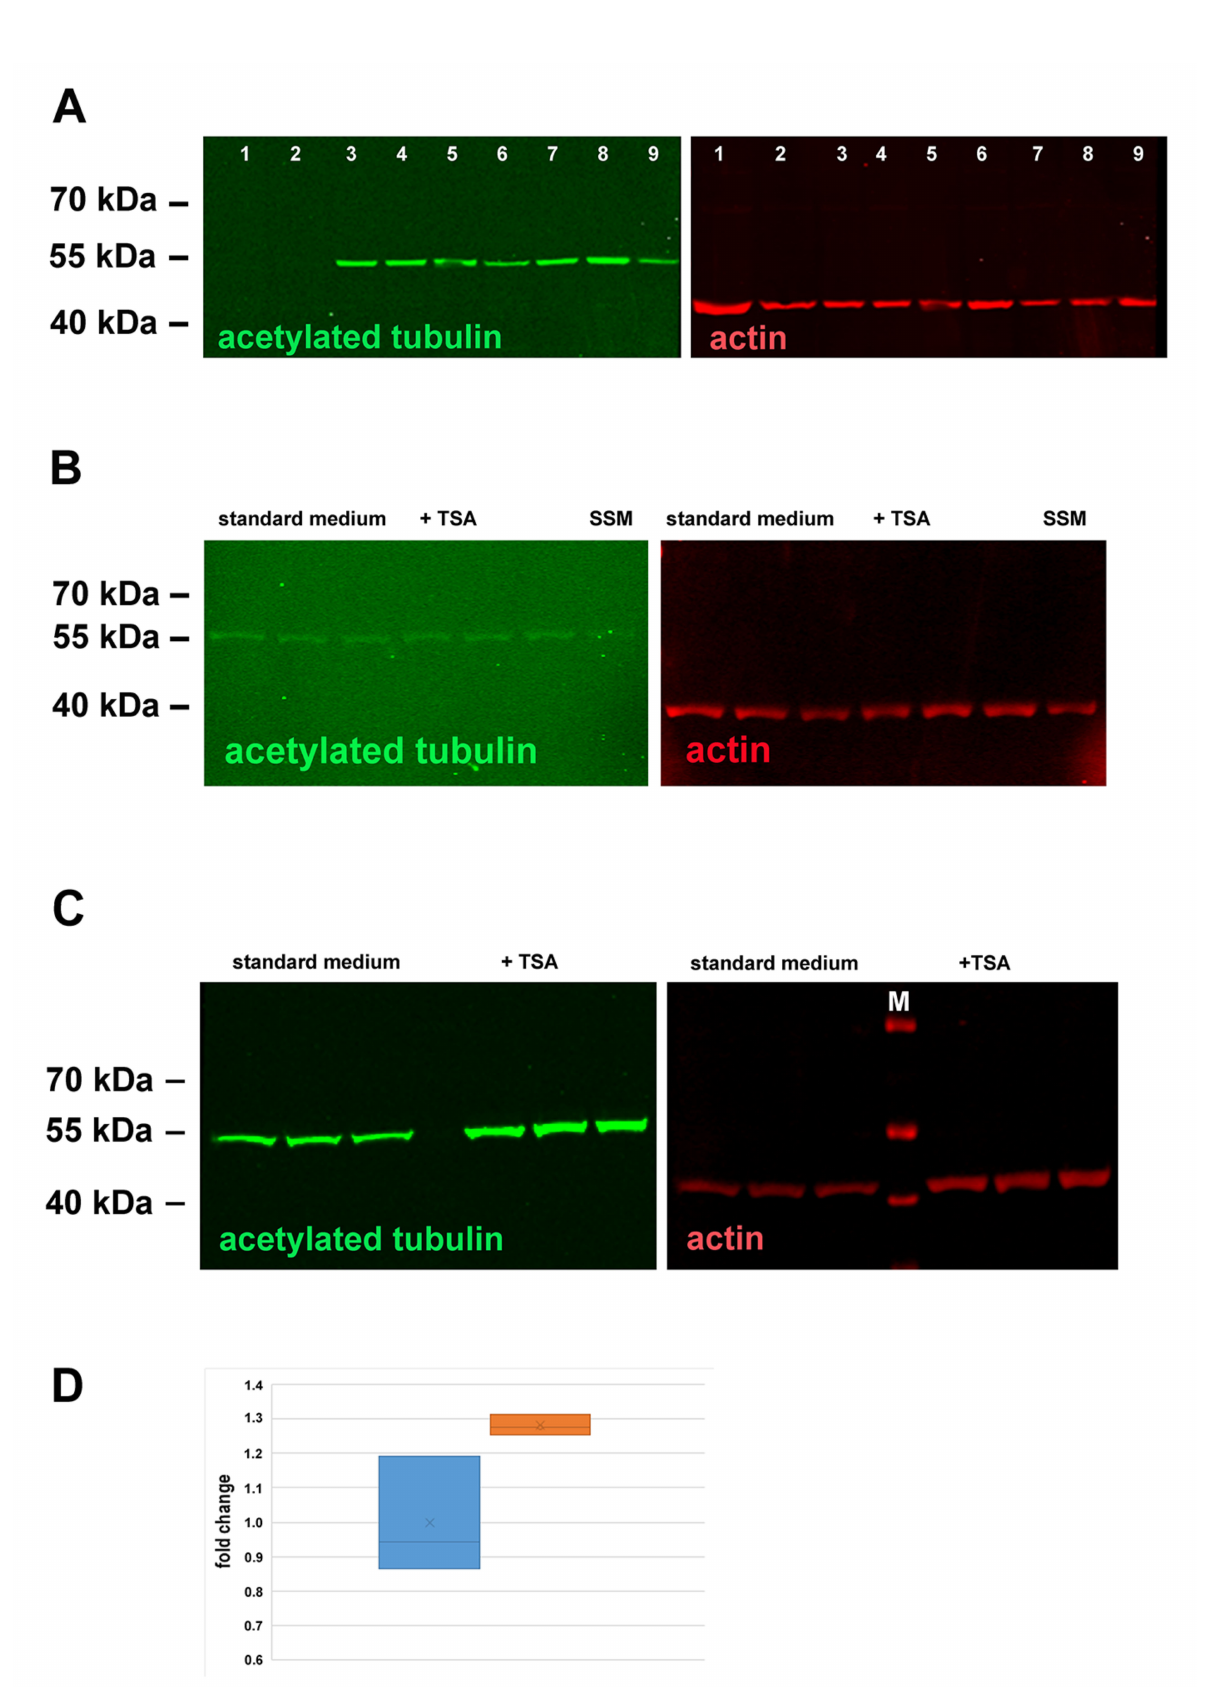
Figure 6. Tubulin acetylation in NIH3T3 F-con and “DSMZ” cells. ( A ) Serum starvation induced an increase in tubulin acetylation in NIH3T3 “DSMZ” but not in NIH3T3 F-con cells. Protein lysates equivalent to ~3 × 10 5 cells were loaded